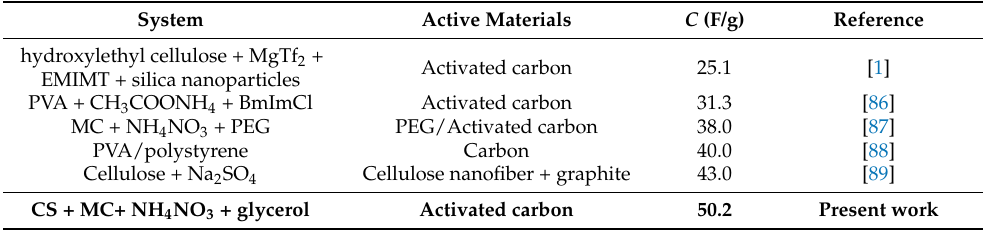
Table 4. Various types of electrochemical double-layer capacitor (EDLC) with their relative electrodes and specific capacitance